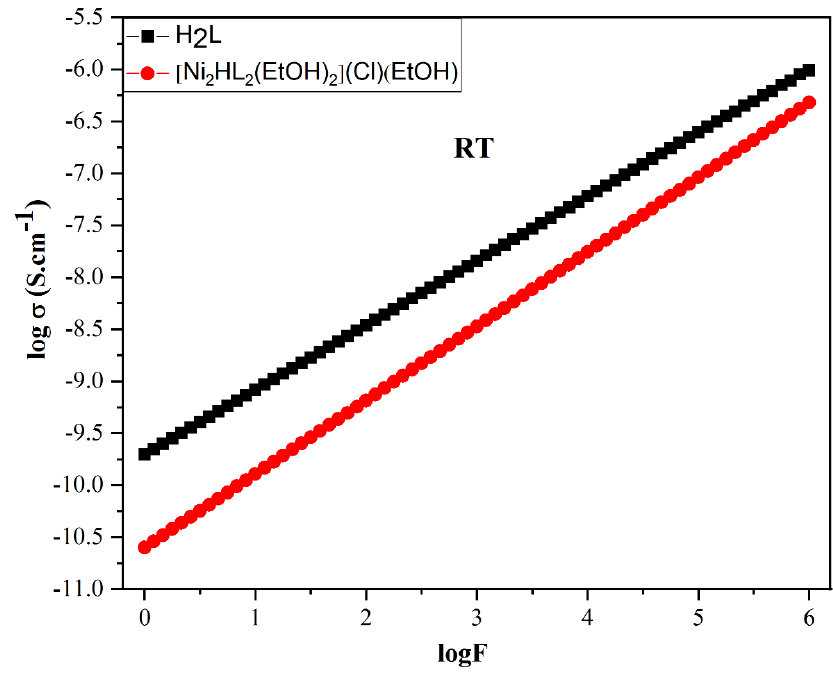
Figure 9. Frequency dependence of the conductivity (log σ ac ) of H 2 L and [Ni 2 HL 2 (EtOH) 2 ](Cl)(EtOH) at room temperature.